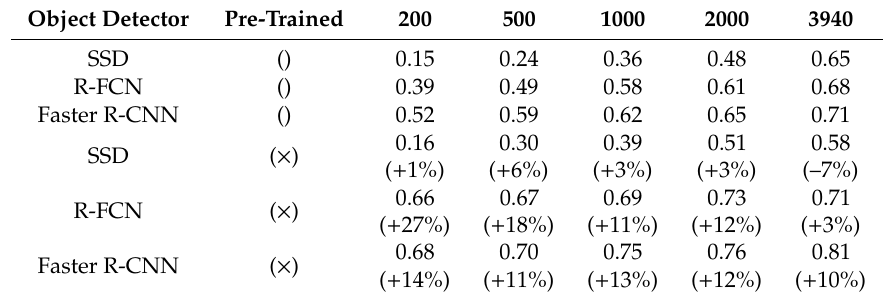
Table 9. Comparison of di ff erent object detectors based on dataset size. The metric is